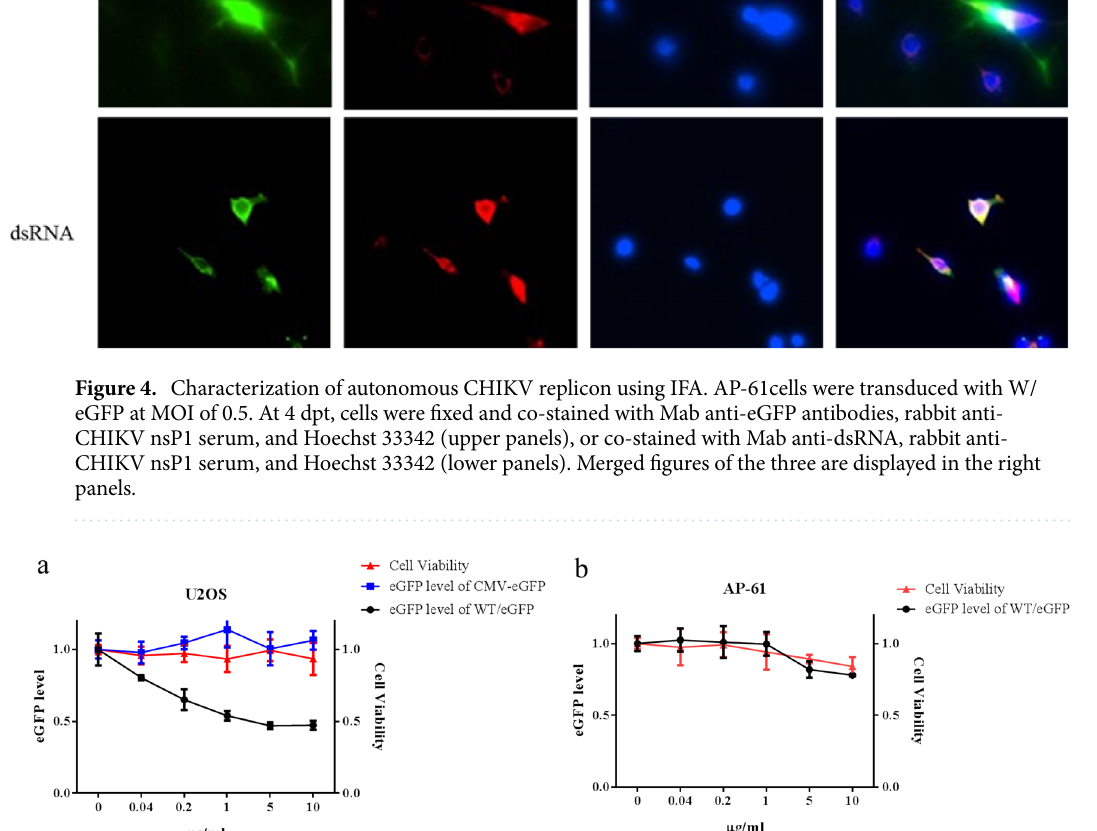
Figure 5. Effect of 6-azaudine in inhibiting CHIKV replicon-mediated expression of eGFP in dual host cell lines. U2OS cells ( a ) were transduced in triplicate using either WT/eGFP or CMV-GFP as a negative control, respectively at an MOI of 5 or 1. AP-61 cells ( b ) were transduced in triplicate using WT/eGFP at an MOI of 1. Mock or transduced cells growth within a range of 6-AU (0–10 μg/ml) over a period of 24 h. eGFP expression and cell viability were quantified using eGFP or MTT. Error bars indicate standard deviation. Data were combined from three independent